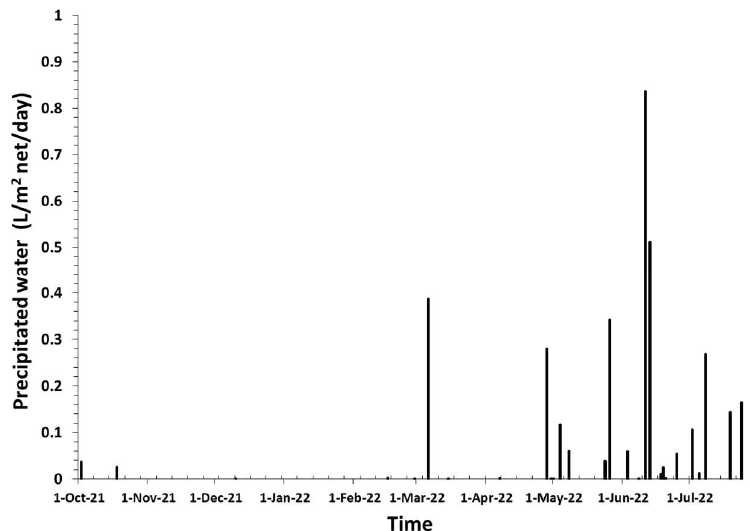
Figure 7. Precipitated fog water events in a fog water collector at site P3 (refer to Table